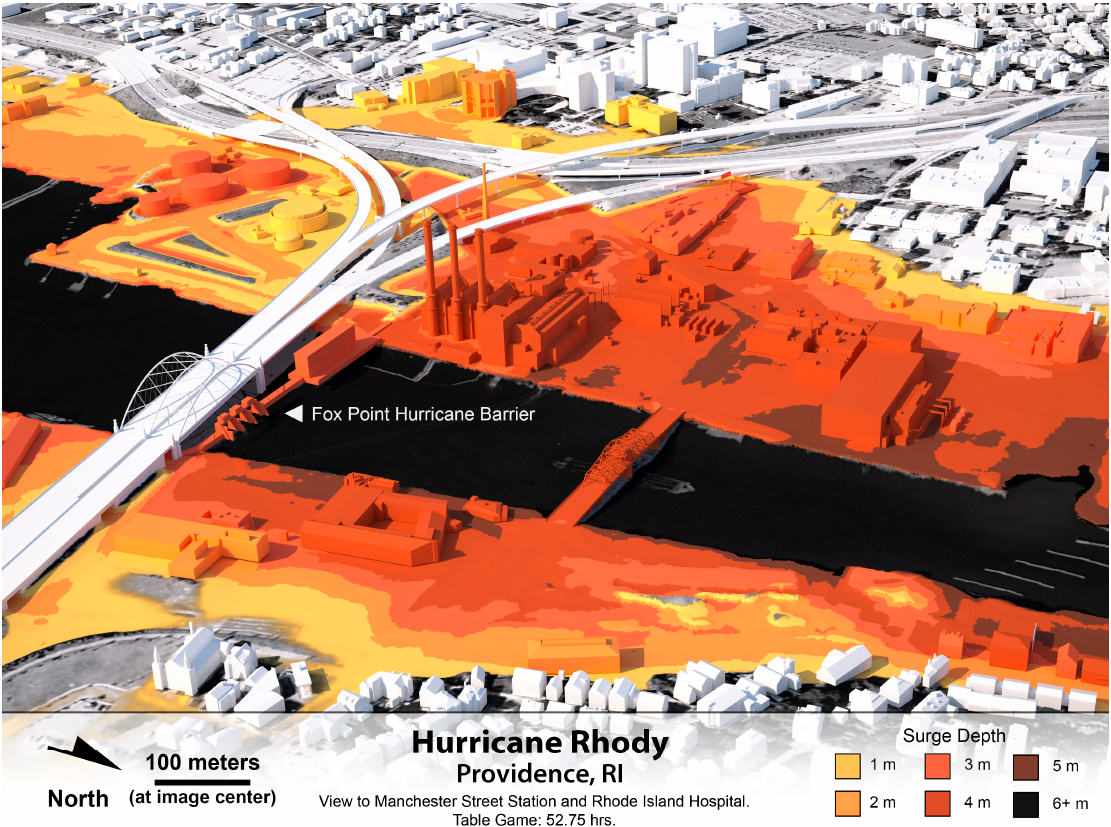
Figure 14. A three-dimensional (3-D) visualization of inundation effects in Providence, RI during the hypothetical Hurricane Rhody after its second landfall. The rivers enter the region from the right, and Narragansett Bay proper lies to the left.